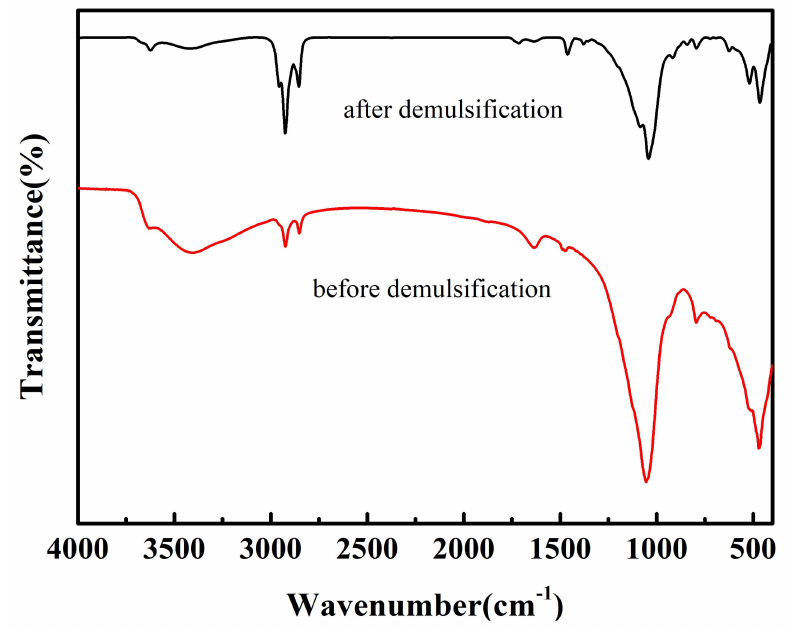
Figure 10. FTIR spectra of Ti-Mt-APTES before and after